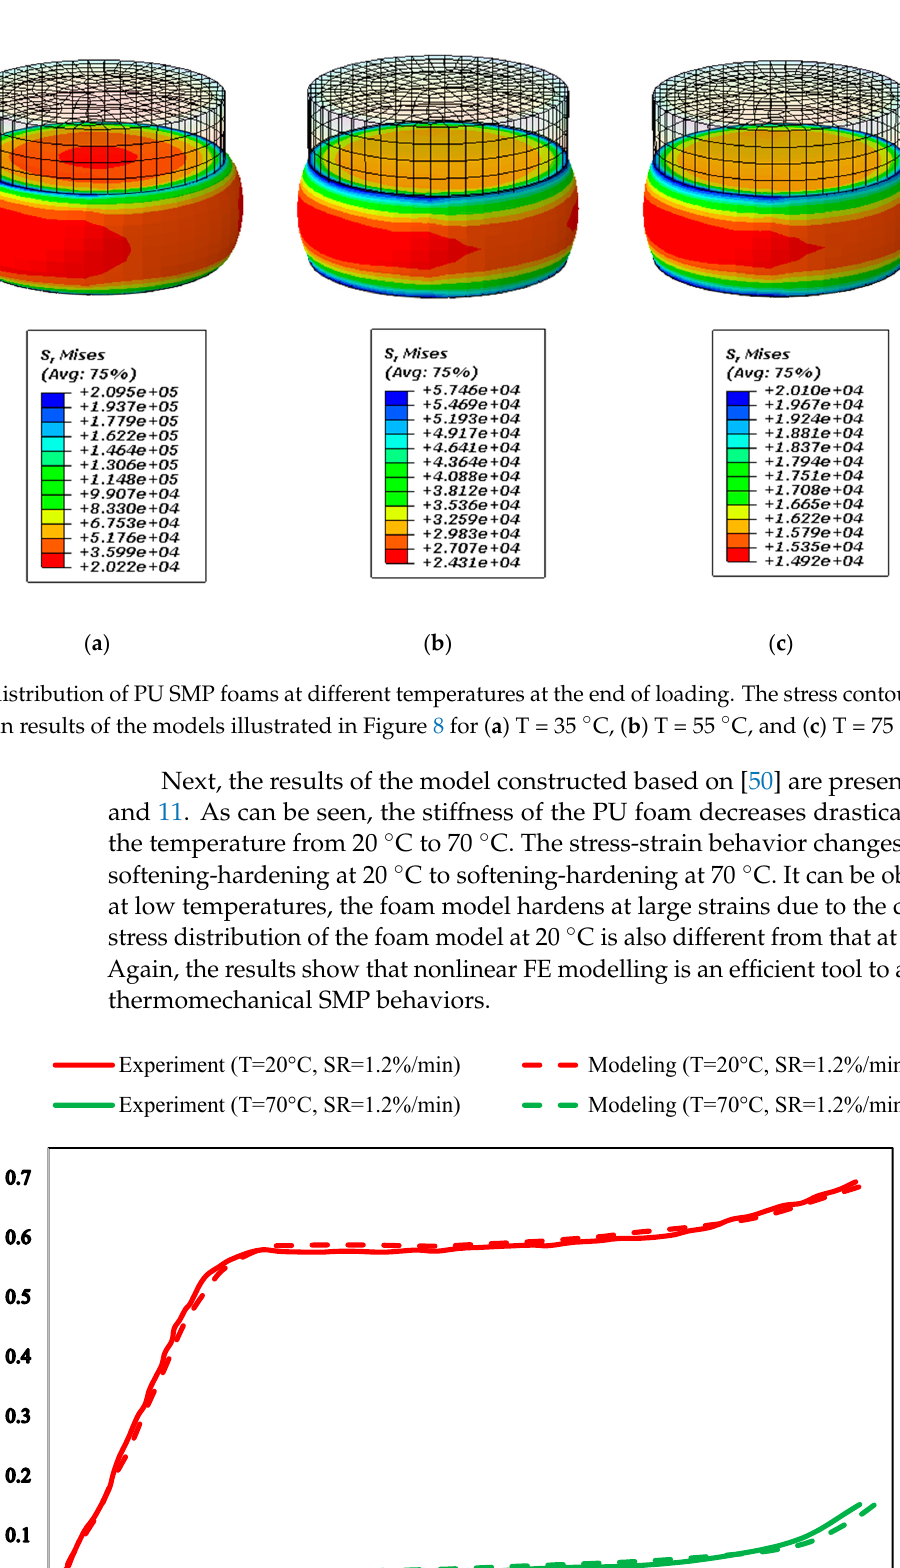
Figure 8. Comparison of numerical and experimental stress-strain curves of PU SMP foams at different temperatures with a strain rate of 10 %/min.